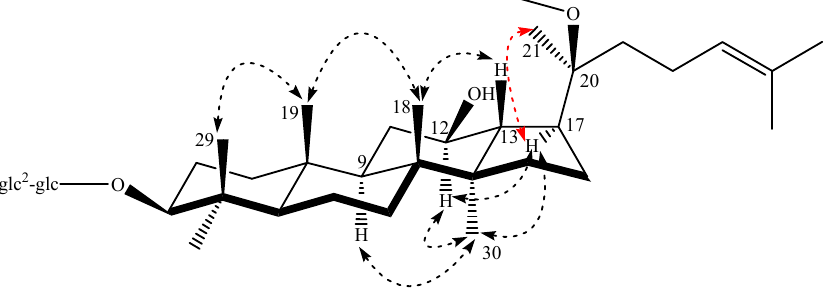
Figure 5. Key NOE correlations for new compound 1 .